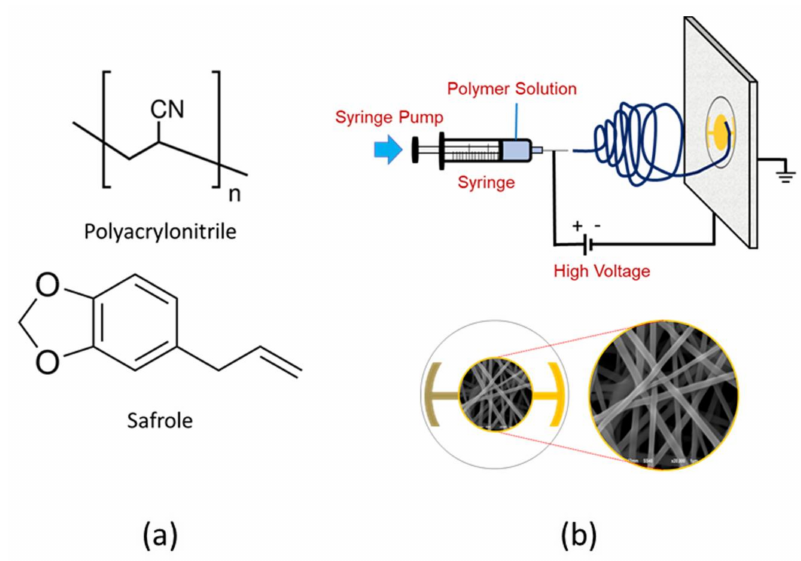
Figure 1. ( a ) Chemical structure of polyacrylonitrile (PAN) and safrole; ( b ) schematic illustration of electrospinning set-up and nanofiber image deposited on the quartz crystal microbalance (QCM) surface.